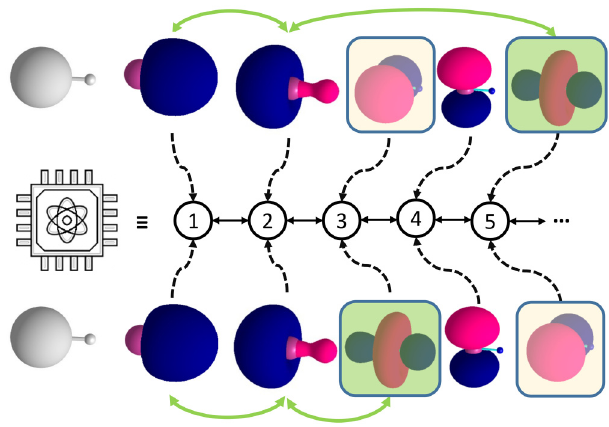
FIG. 1. Correlation-informed permutation schematics for the example of a LiH molecule in a reduced active space of the STO- 3G basis: direct encoding of five α spin-orbitals into five physical qubits on a linear architecture quantum chip before (top) and after (bottom) permutation based on orbital entanglement information (green double-headed arrows show strongly interacting orbitals).